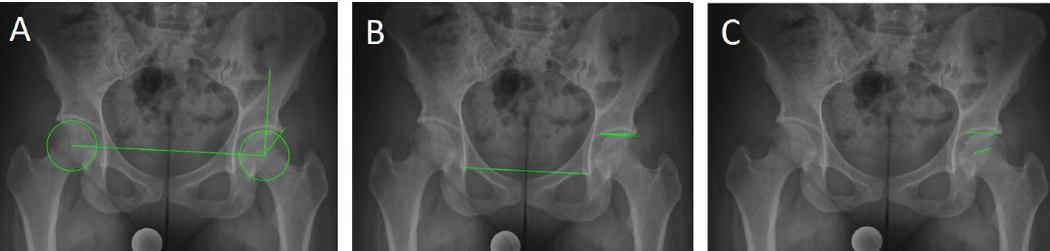
Figure 2. Radiographic Measurements. ( A ) Lateral Center–Edge Angle: calculated by drawing a best-fit circle around the inferior and medial margins of the femoral head. The angle is measured between 2 lines drawn from the center of the circle, one running vertically along the longitudinal axis of the pelvis and the other running along the acetabular sourcil edge 23 . ( B ) Acetabular index: measured by drawing a horizontal line parallel to the transverse pelvic axis, at the most medial edge of the sclerotic sourcil, and then making a second line extending from the medial edge to the most lateral aspect of the sourcil 24 . ( C ) Femoroepiphyseal acetabular roof index: formed by 2 lines connecting the acetabular roof inclination and the femoral head physeal scar 15